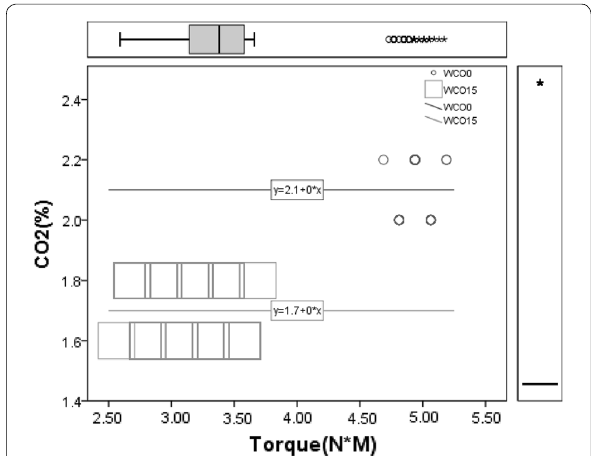
Fig. 12 Scatter plot diagrams for the exhaust characteristics versus torque output [CO